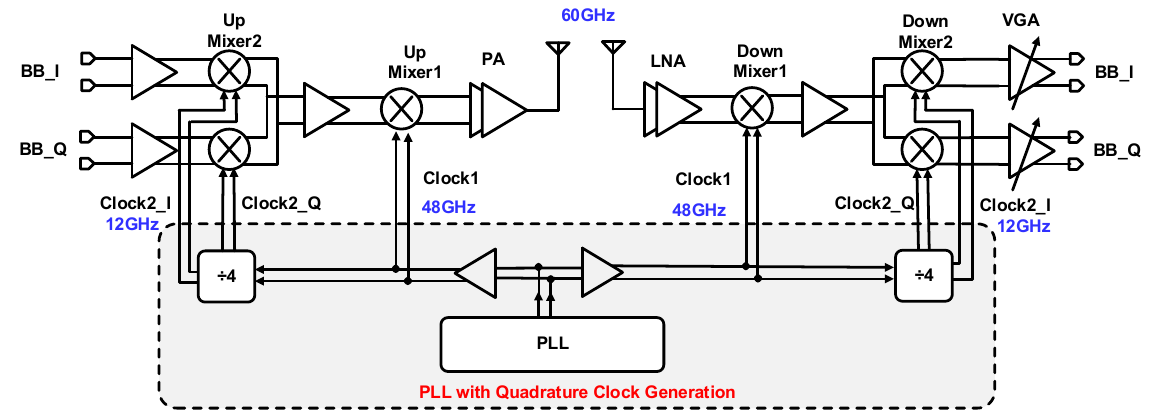
Figure 1. Block diagram of the sliding-IF 60 GHz transceiver.